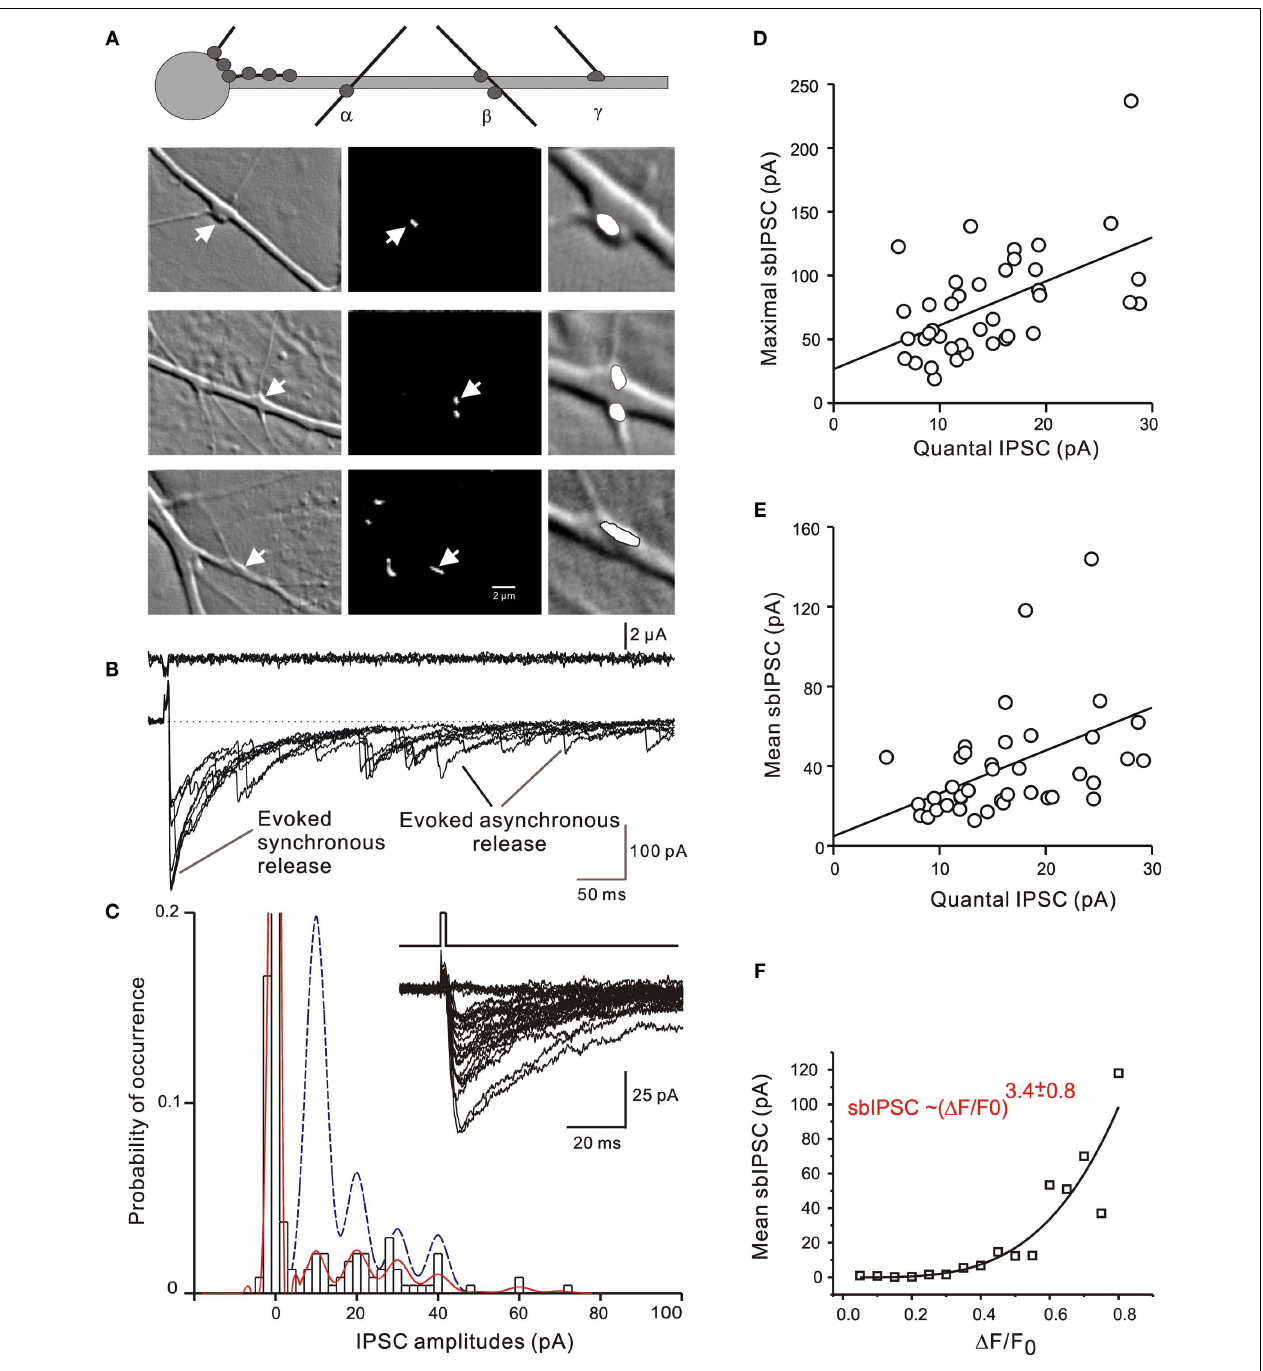
distribution and binomial fitting of sbIPSCs (bars and solide line) and dIPSCs (dashed line) for the solitary bouton illustrated in the upper row images of (A) . dIPSCs were sampled during a period of 250–500ms after the pulse. (D,E) Quantification of the results for maximal and mean sbIPSCs suggesting a quantal content > 1. (F) Relationship between the mean sbIPSC amplitude and the maximal amplitude of the presynaptic bulk Ca 2 + transient [Ca 2 + ] pre recorded from a presynaptic area delineated on the basis of vesicular staining. (Modified from Kirischuk et al.,